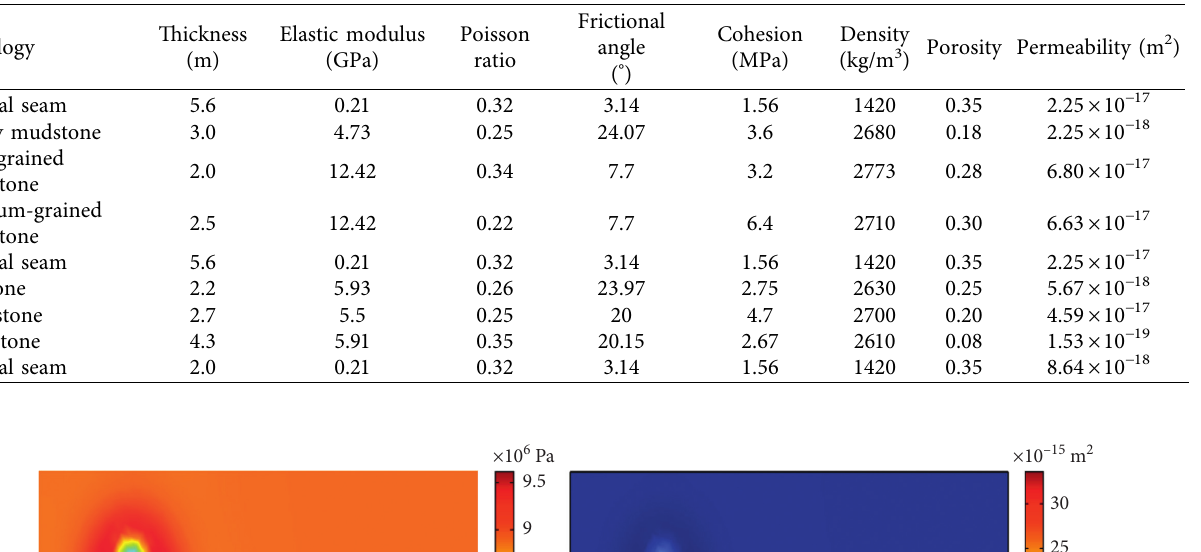
Table 2: Basic parameters of main coal strata in numerical simulation